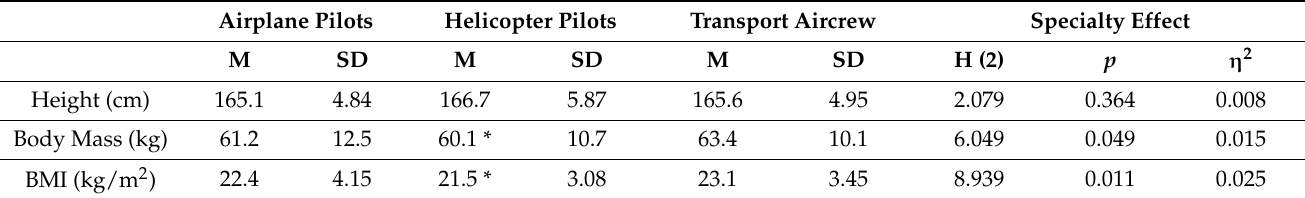
Table 1. Results of body composition variables by